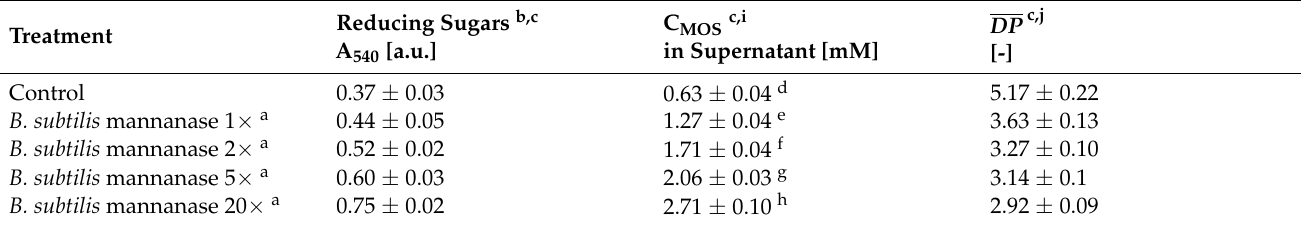
Table 2. Soluble mannans in enzymatically treated and untreated PKC.